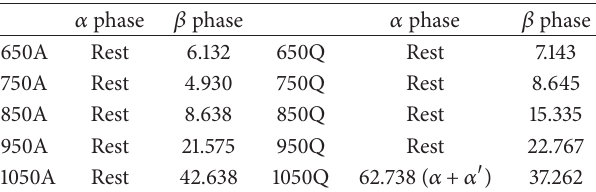
Table 1: Volume fraction results of 𝛼 / 𝛽 𝛽 󸀠